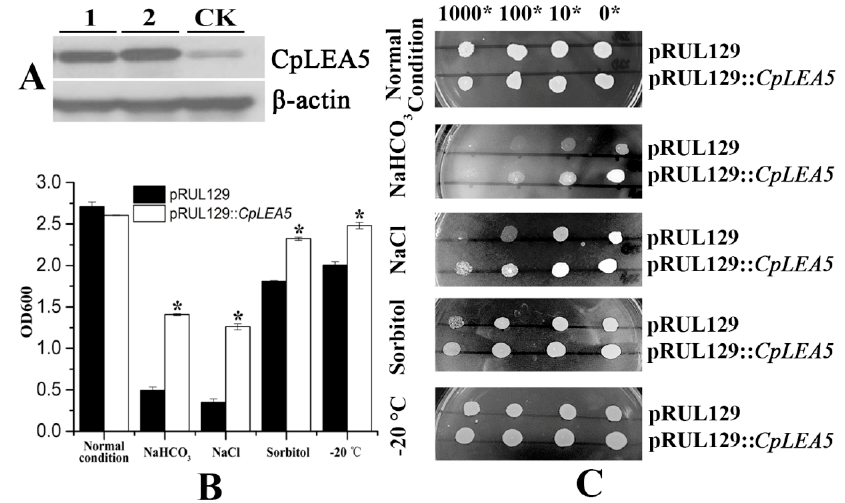
Figure 5. Abio-stress resistance assay in CpLEA5 -overexpressed yeast. ( A ) Western-blot analysis of the CpLEA5 -overexpressed yeast; 1 and 2 represent protein numbers extracted at different times; CK represent empty-vector strains; ( B ) OD 600 value of yeast transformants in response to different abiotic stressors. Data are means ± standard deviations of three replications. * Significant difference at p < 0.05; ( C